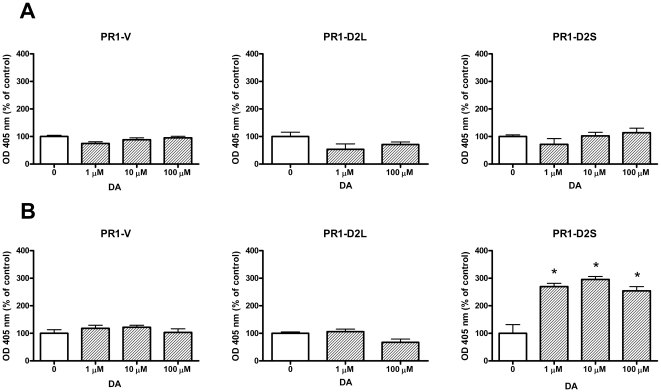
DA increases apoptosis in PR1-D2S cells incubated in the presence of E2.PR1-V, PR1-D2L or PR1-D2S cells were cultured with DMEM-F12-SS in the absence (A) or presence of E2 (1 nM, B) for 48 h. Then the cells were incubated with DA (1 µM-100 µM) in the presence or absence of E2 for 4 h and apoptosis was detected by ELISA. Each column represents the mean ± SE expressed of OD as the percentage of control without DA (n = 5 wells/group). Data were analyzed by ANOVA followed by Dunnett's test. * p<0.05 vs control without DA.